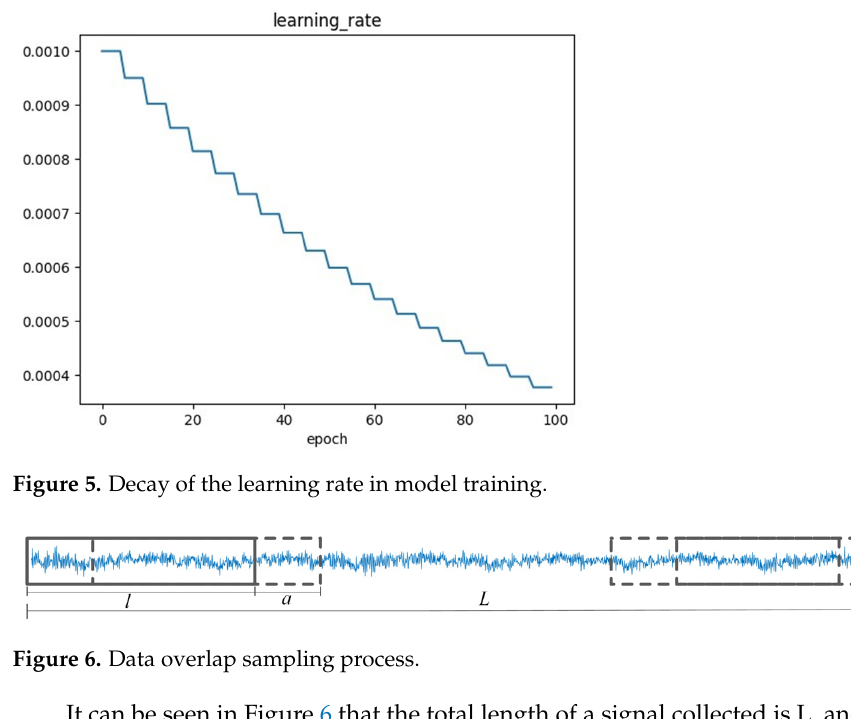
Figure 6. Data overlap sampling process.